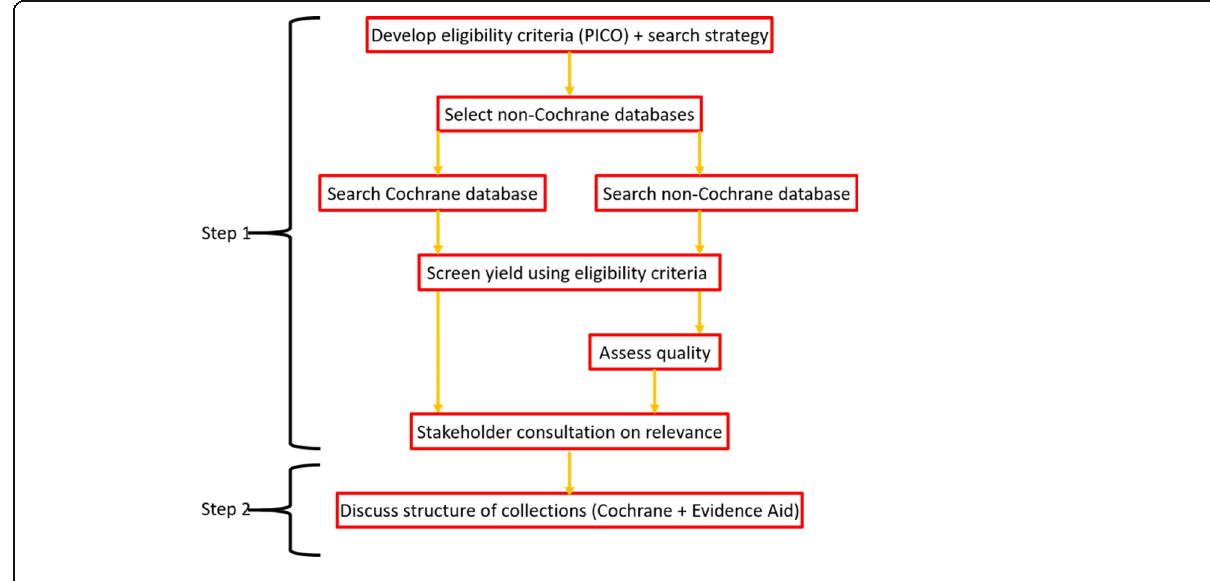
Fig. 1 Steps followed to build the collection of reviews on preventing and treating MAM and SAM*. Note: quality of individual reviews was